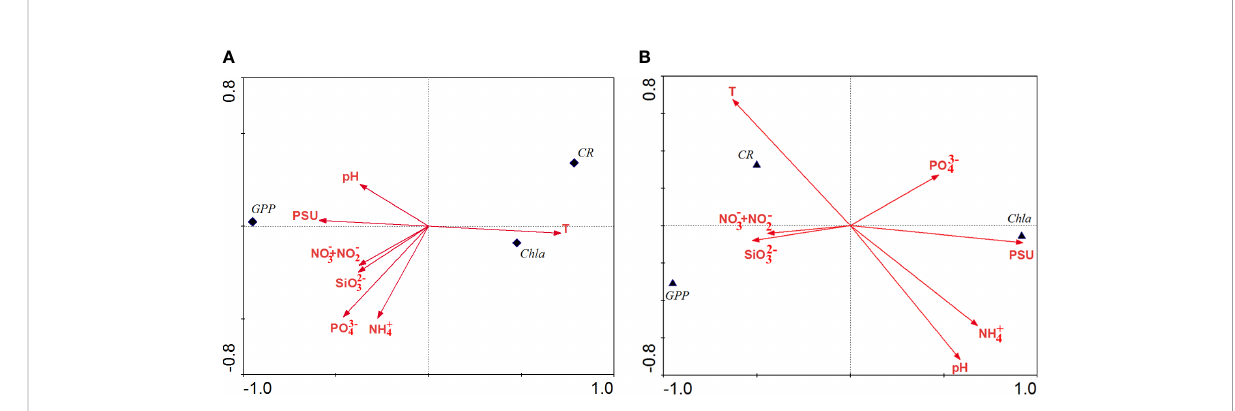
FIGURE 4 Canonical correspondence analysis between ecological parameters and environmental factors. (A) summer. (B) winter. Chl- a , chlorophyll a ; CR, community respiration; GPP, gross primary production.